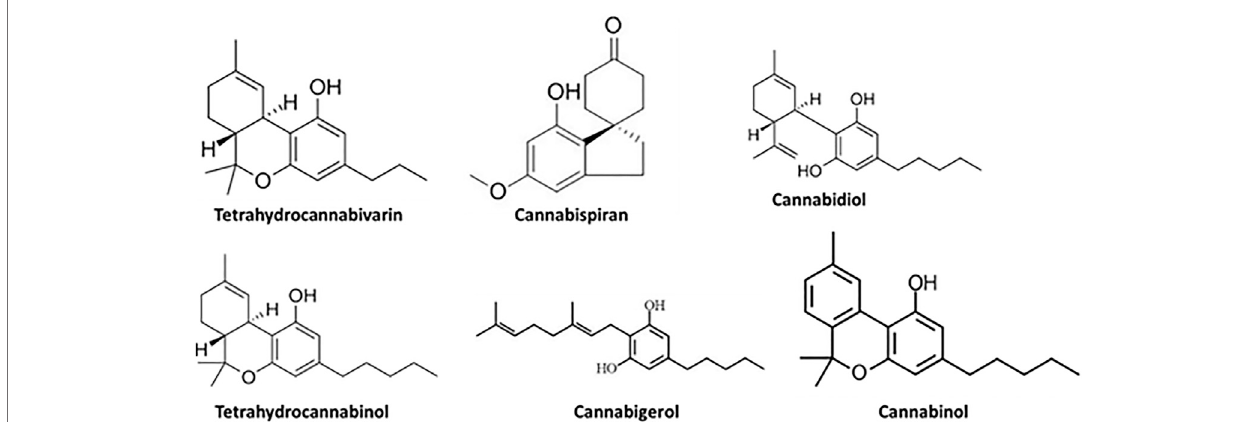
FIGURE 2 | GC-MS identi fi ed compounds from C. sativa infusion.